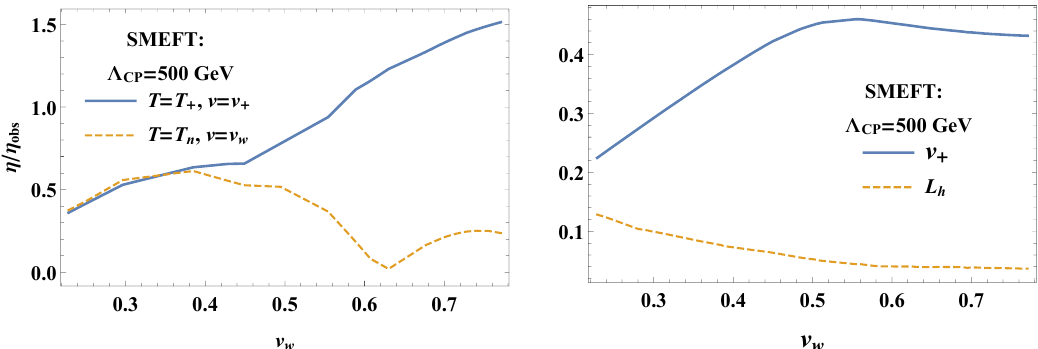
Figure 12 . Left: normalized BAU against the wall velocity computed for the SMEFT. Right: the variation of the wall properties as function of velocity. The CP-violating cut-off scale was fixed to Λ = 500 GeV in both CP